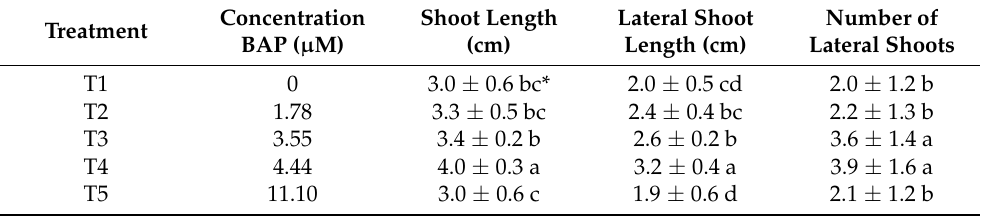
Table 2. Effect of different concentrations of BAP on in vitro C. mucronata shoot multiplication using 1.5 cm long explants. Treatment